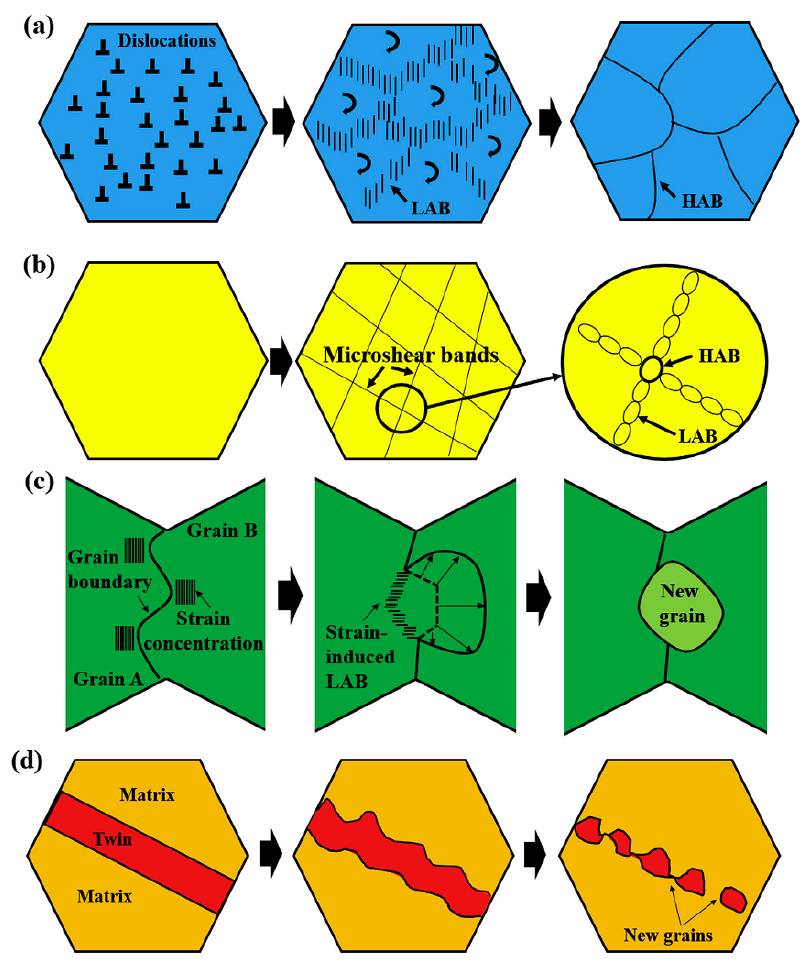
Figure 3. Schematics of several grain refinement mechanisms during the CSA-FSP of the AZ31B magnesium alloy including ( a ) strain-induced CDRX, ( b ) micro-shear band induced CDRX, ( c ) strain-induced DDRX, and ( d ) twinning-induced DRX (Reprinted with permission from ref. [57]. Copyright 2019 Elsevier